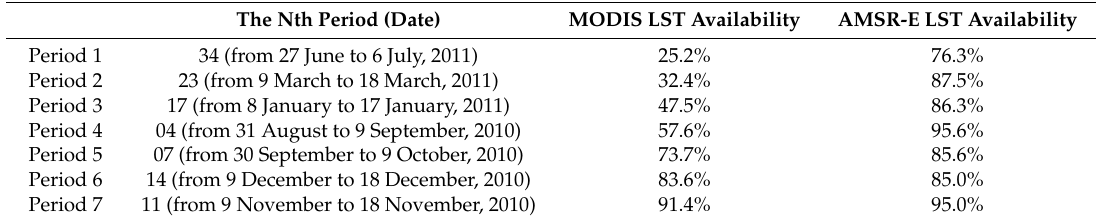
Table 2. Dates and availabilities of the selected